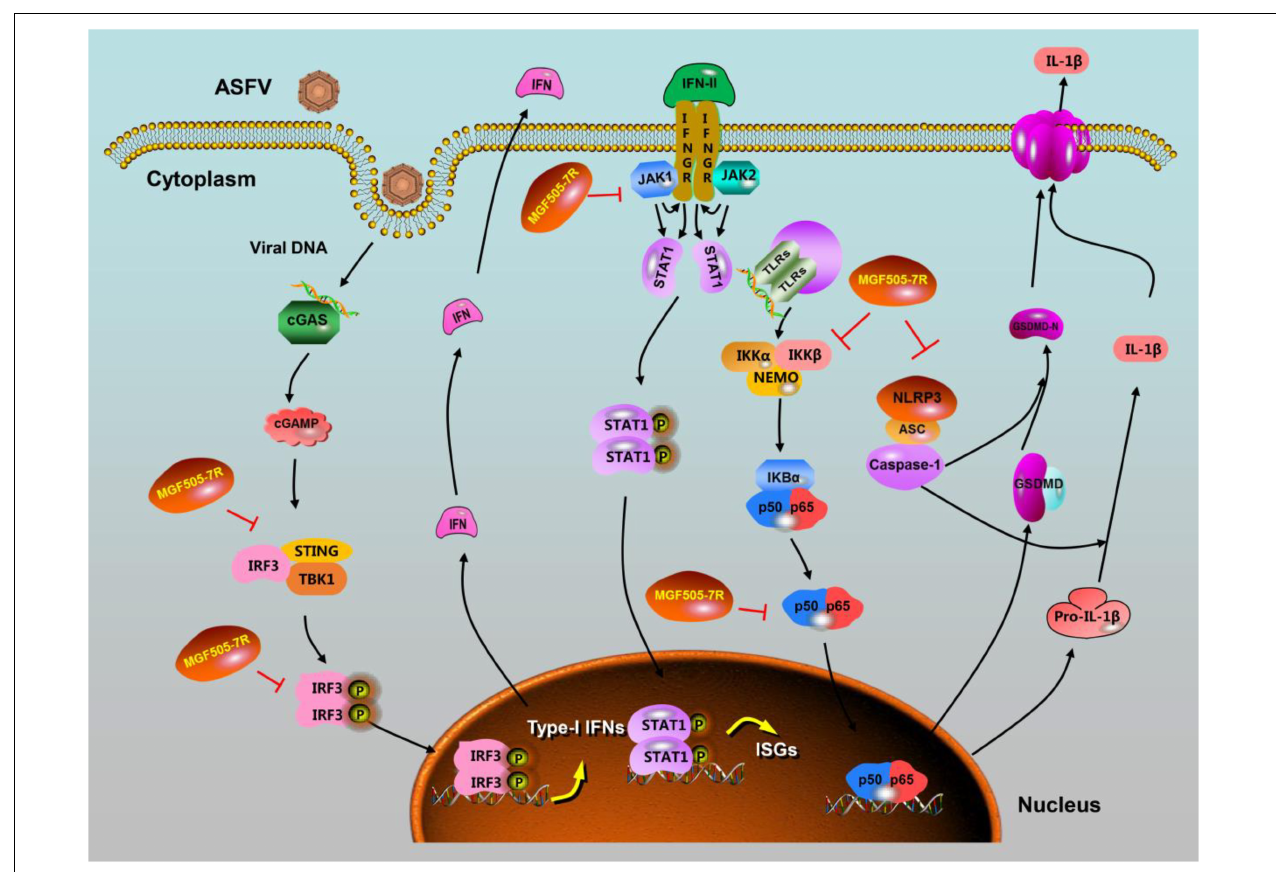
FIGURE 1 | ASFV pMGF505-7R is a multifunctional protein involved in viral